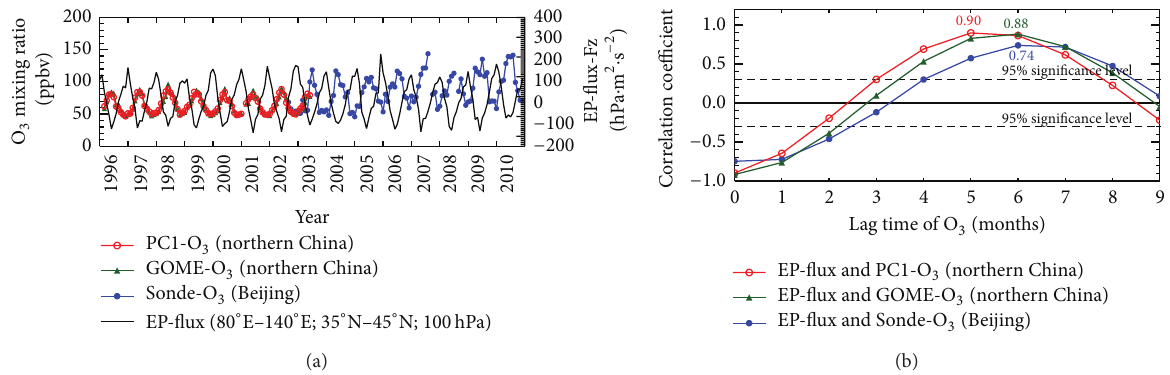
Figure 5: (a) Time series of the regional mean (80 ∘ E–140 ∘ E; 35 ∘ N–45 ∘ N) vertical EP-flux at 100 hPa between January 1996 and December 2010, PC1 decomposed from GOME TOVMR (PC1-O 3 ) and GOME TOVMR (GOME-O 3 ) between March 1996 and June 2003 over northern China, and ozonesonde observed tropospheric ozone mixing ratio (Sonde-O 3 ) over Beijing from September 2002 to December 2010. (b) Lag correlation coefficients between EP-flux and the time series of ozone (red: PC1-O 3 over northern China; green: GOME ozone over northern China; blue: ozonesonde over Beijing).